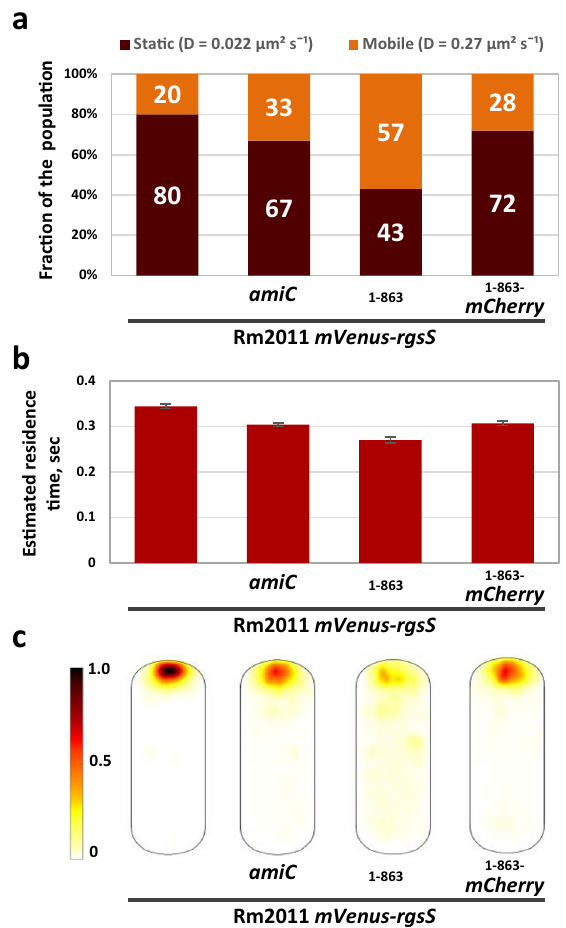
Fig. 5 AmiC and SPOR RgsS facilitate stable positioning of mVenus-RgsS molecules at the cell pole. Single-molecule tracking of mVenus-RgsS, mVenus-RgsS 1 – 863 , and mVenus- RgsS 1 – 863 -mCherry molecules in cells from exponential phase TY cultures. Single molecule tracks were collected from cells, originating from three independent biological replicates. Numbers of single molecule tracks analyzed: Rm2011 mVenus-rgsS , n = 7556; Rm2011 mVenus-rgsS amiC , n = 5439; Rm2011 mVenus-rgsS 1-863 , n = 2296; Rm2011 mVenus-rgsS 1-863 -mCherry , n = 5469. a Relative fraction size of molecule populations with two different normalized diffusion constants, determined by Gaussian-mixture model (GMM) fi t. Statistics analysis and numerical data are presented in Supplementary Table 9. b Estimated average residence times (time a molecule stays in a radius of 128.7 nm for more than nine 20 ms intervals), calculated from single molecule tracking data. Data presented as mean values of residence times calculated for each trajectory. Error bars indicate the standard deviation of the mean. Numerical data is presented in Supplementary Table 9. RgsS 1 – 863 -mCherry molecules trajectory distribution in a normalized cell. The color code on the left indicates the probability of the molecules to be detected in the given cell